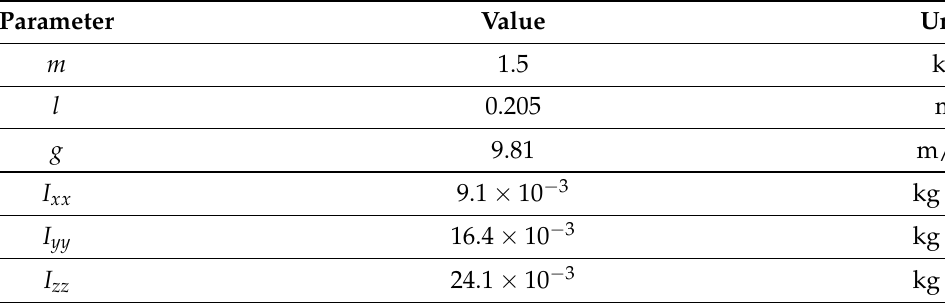
Table 1. Parameters of the 3DR Solo